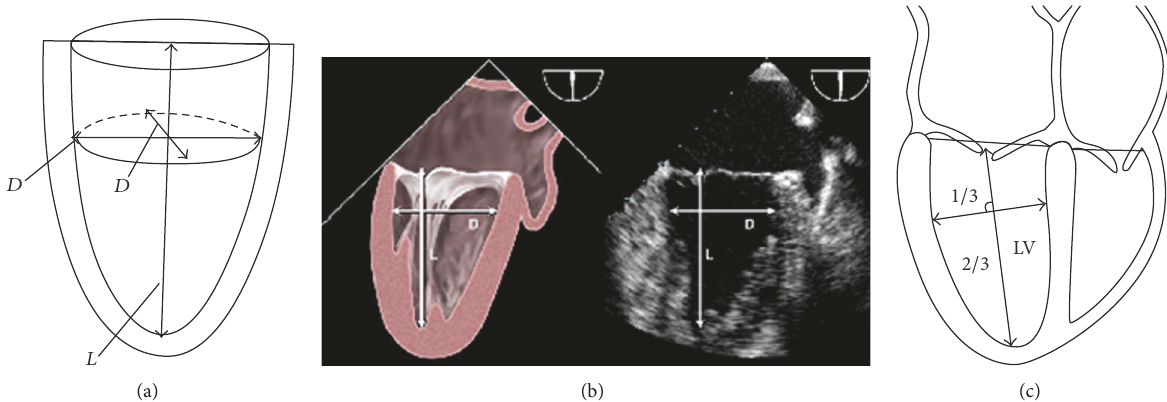
Figure 4: We have, in (a), an adaptation of a figure withdrawal from [8]. In (b), with an adaptation from [16], on the left, we have a more realistic picture of the LV and, on the right, there is a real image obtained through echocardiography. In both cases, the adequate way of obtaining the measures is highlighted. In (c), adapted from [17], one of the possibilities of obtaining the measures is presented, in which it is established that 𝐷 value must be obtained at the point that divides 𝐿 into 1/3 and 2/3 proportions.